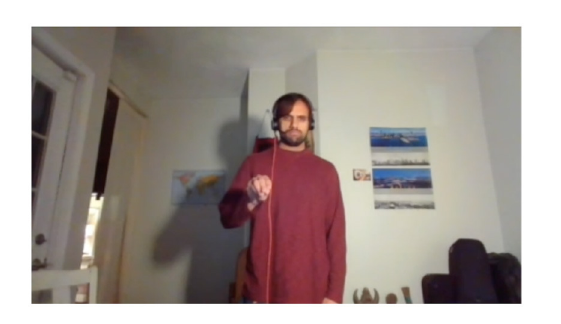
FIGURE8 Iconic plate gesture for “grasp the